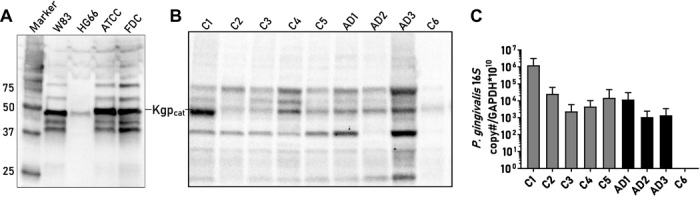
Identification of P. gingivalis–specific protein and DNA in cortex from control and AD patients.(A) WB with four different strains of P. gingivalis and CAB102 detection of typical molecular weight bands for Kgp in bacterial lysates. (B) IP using brain lysates from nondemented controls (C1 to C6; ages 75, 54, 63, 45, 37, and 102 years, respectively) and AD patients (AD1 to AD3; ages 83, 90, and 80 years, respectively) using CAB102 with subsequent WB reveals the ~50-kDa Kgp catalytic subunit (Kgpcat), along with higher– and lower–molecular weight Kgp species seen in (A). (C) qPCR from DNA isolated from the same brain lysates as the protein samples analyzed in (B) shows a positive signal in nondemented control (C1 to C5) and AD (AD1 to AD3) samples. Sample C6 from the 102-year-old nondemented control patient had no detectable qPCR signal in (C) and very faint bands indicating near absence of Kgp (B) (mean with SEM error bars of repeat qPCR runs).